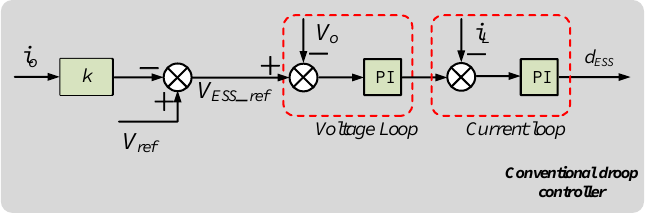
Figure 7. Block diagram of a traditional droop controller.